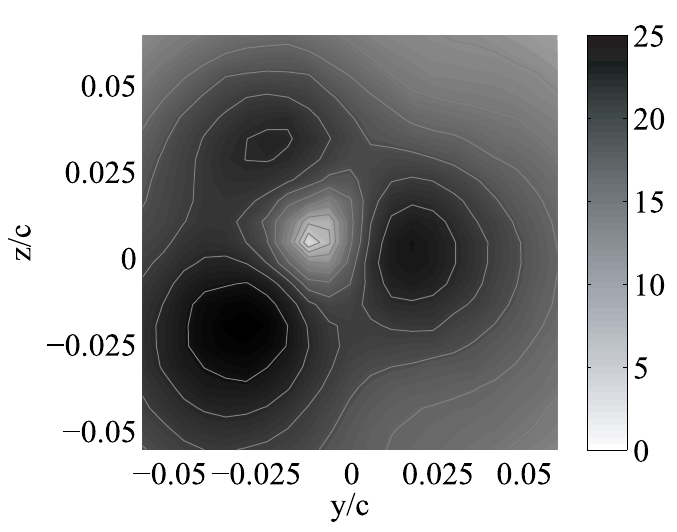
Fig. 10 Angle of velocity vector against x